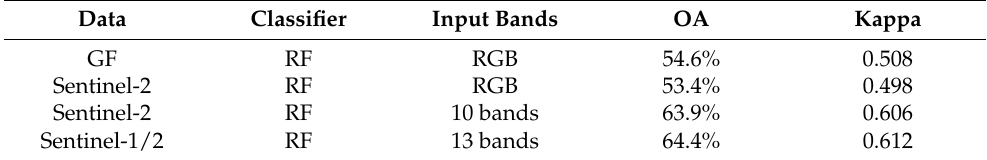
Table 5. Influence of the input bands on the RF classification